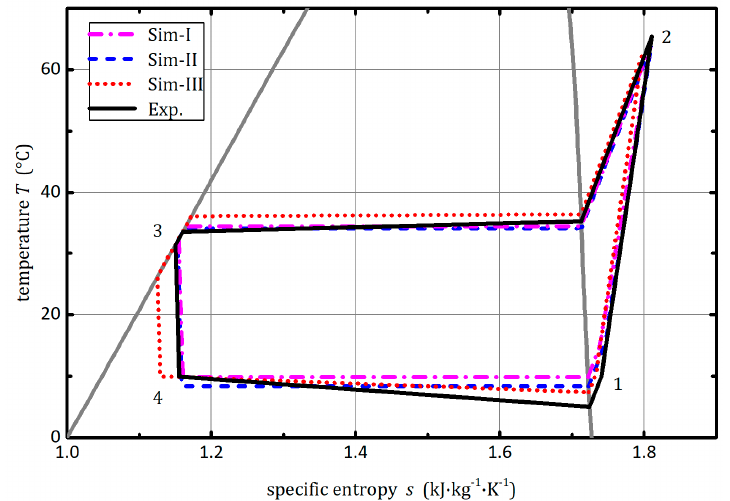
Figure 3. Temperature–entropy (T–s)-plot of the thermodynamic cycles resulting for R134a from the different simulation levels and the experiments.